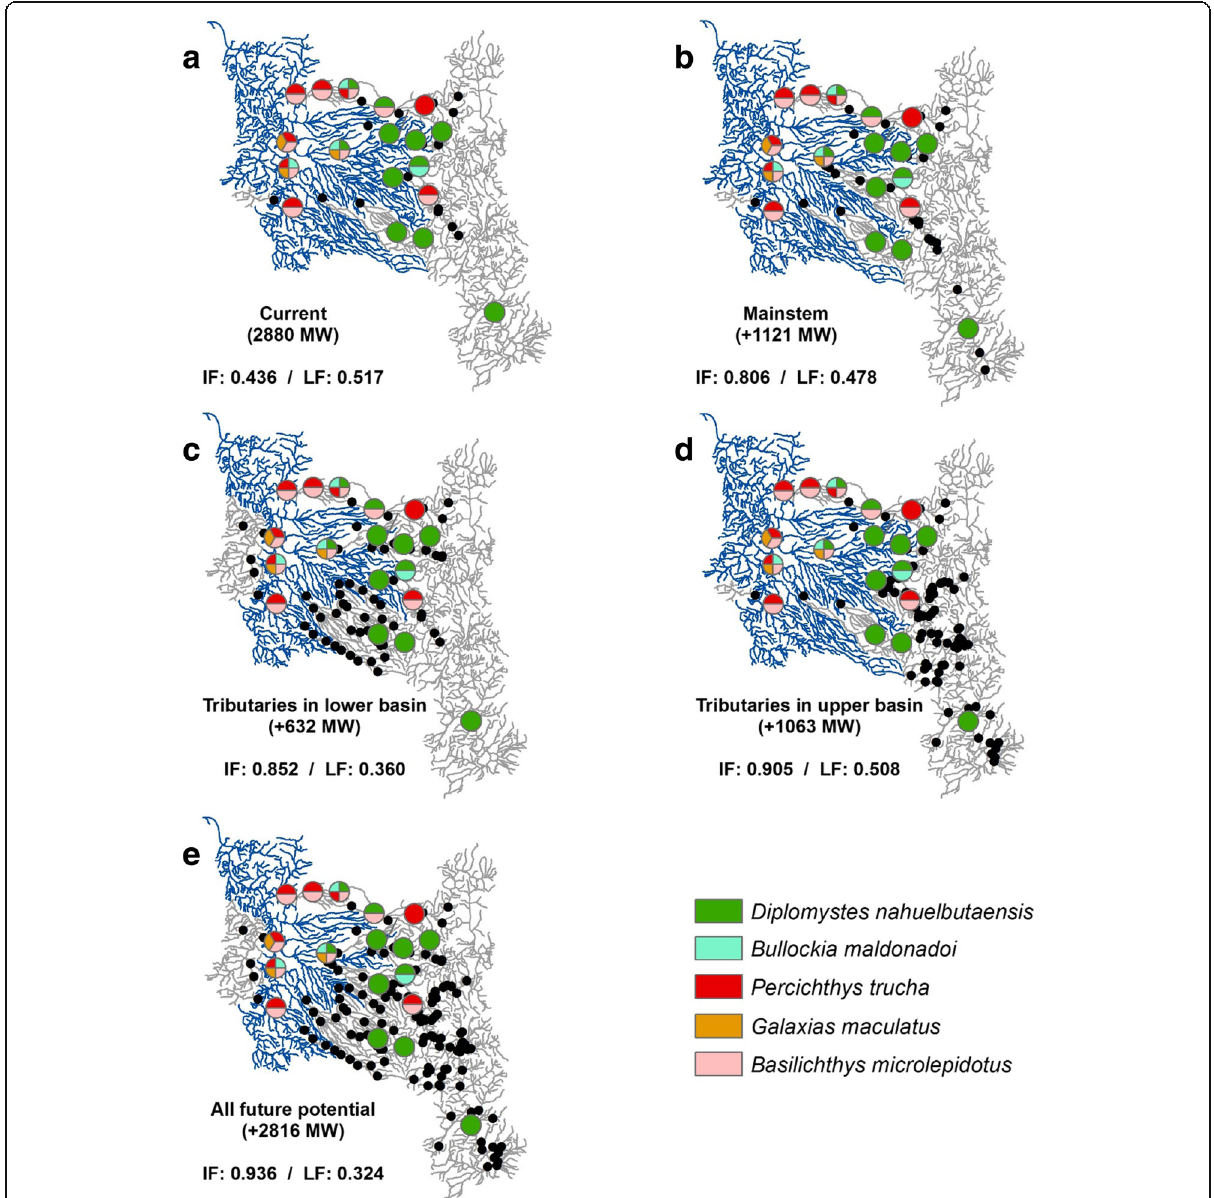
Fig. 8 Configurations of planning optimization for future hydropower plants on Biobío river network and distribution the five native fish species of high conservation value. Each configuration ( a - e ) show impacted (gray) and non-impacted (blue) fragments of the basin according to current and future hydropower plants locations (black dots). Furthermore the hydropower potential and values of corresponding fragmentation indices are indicated. The current distribution (based on presence /absence data) of native freshwater fishes was described using pie